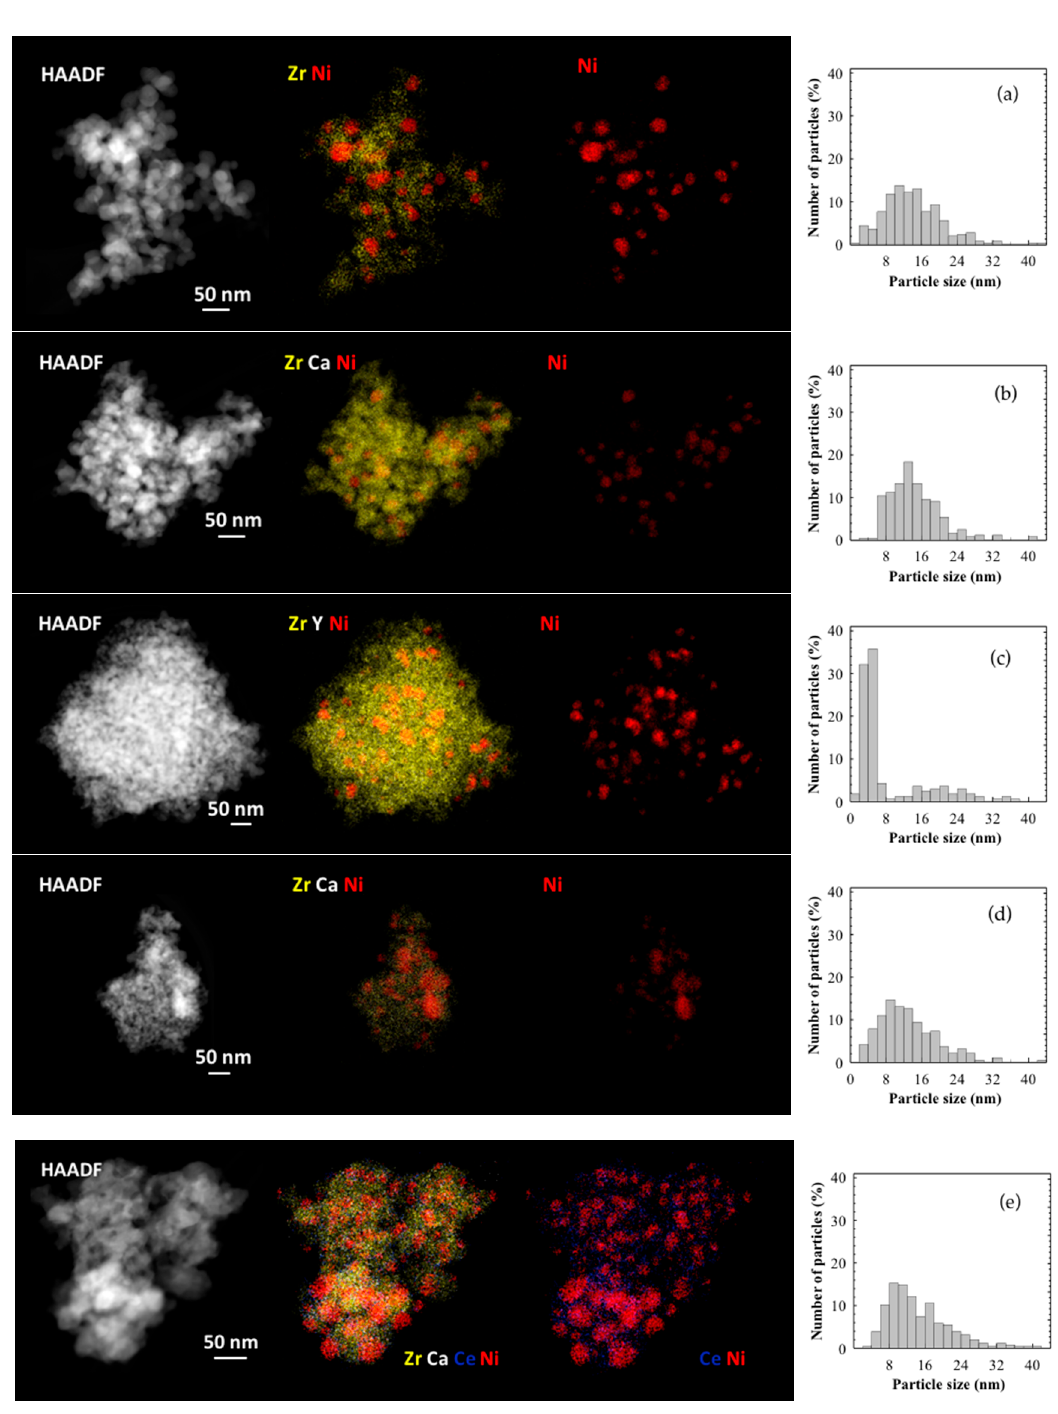
Ni8YSZ; ( d ) Ni14CSZ; and ( e ) NiCe4CSZ.